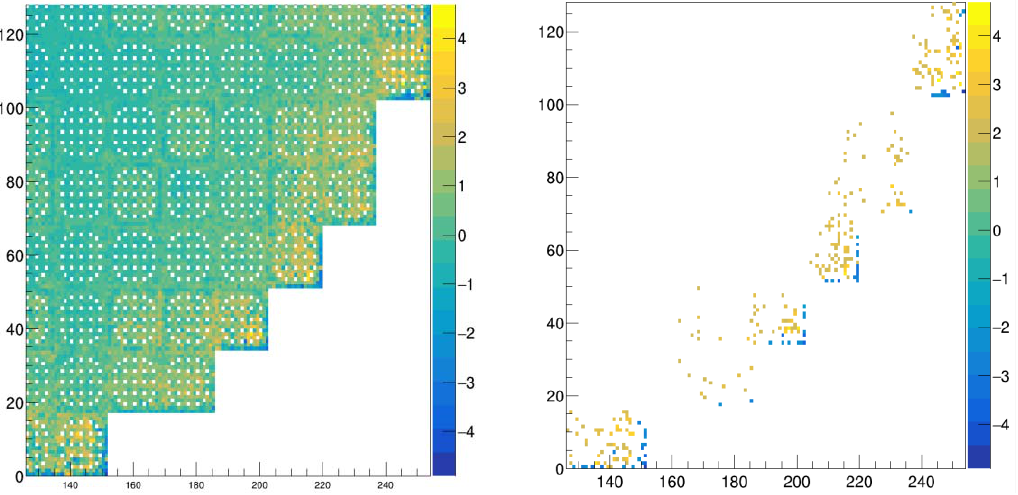
Figure 6. Fission rate distribution comparison (MCNP-CASMO/CASMO) on the pin level (left) for a hybrid UOX/MOX loading with Hf rods and filtering the discrepancies above 2% for a hybrid UOX/MOX core loading (right).